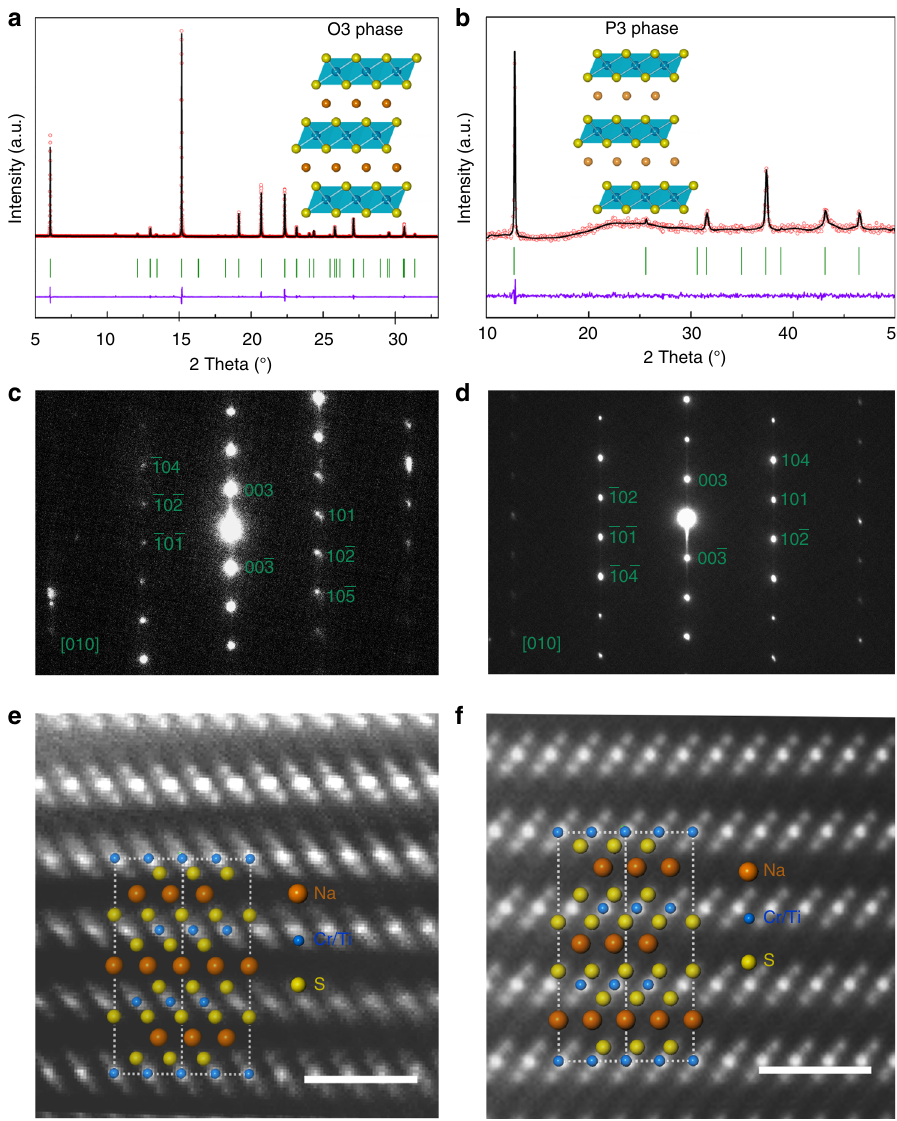
Fig. 4 Structure characterization. a XRD re fi nement patterns of powder NaCr 2/3 Ti 1/3 S 2 (red circles), fi tted pro fi le (black solid line), and difference (purple solid line) using synchrotron XRD (wavelength 0.6884 Å). Bragg positions are indicated as green vertical tick marks. The inset is structure schematic of NaCr 2/3 Ti 1/3 S 2 observed along a-axis, legend: orange (Na), blue (Cr/Ti), and yellow balls (S). Impurity peaks at 11 ° and 14 ° can be attributed to Na 2 SO 3 as a common impurity in commercial Na 2 S. b XRD re fi nement patterns of powder Na 0.66 Cr 2/3 Ti 1/3 S 2 and structure schematic of Na 0.66 Cr 2/3 Ti 1/3 S 2 as inset. c Selected-area electron diffraction (SAED) pattern of NaCr 2/3 Ti 1/3 S 2 taken from [010] zone axis. d SAED pattern of Na 0.66 Cr 2/3 Ti 1/3 S 2 taken from [010] zone axis. e HAADF-STEM image of the pristine NaCr 2/3 Ti 1/3 S 2 particle along a / b- axis, scale bar 1 nm. f HAADF-STEM image of the Na 0.66 Cr 2/3 Ti 1/3 S 2 particle along a / b- axis, scale bar 1